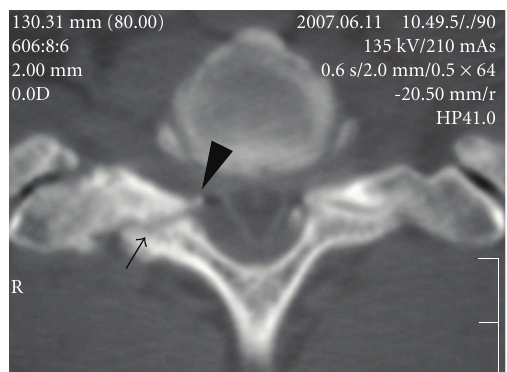
Figure 4: Computed tomographic myelography at C7/T1 level. The spinal cord is compressed from both sides and shows atrophy. The right C7/T1 facet joint indicates severe arthrosis (arrow) with bony spur extending into the spinal canal